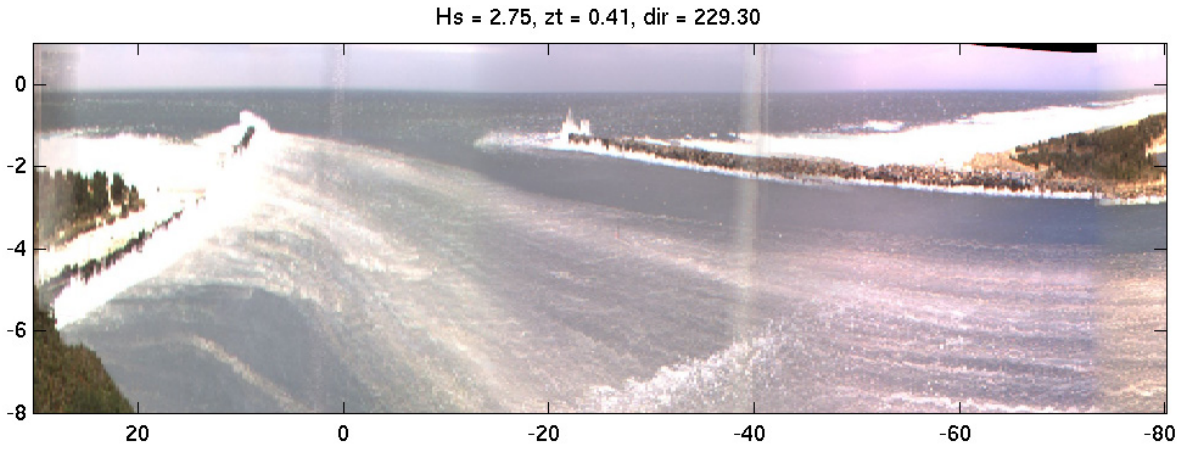
Figure 24. Pan “brightest” image of wave overtopping of the south jetty near the beach but not overtopping further offshore. Foam and perhaps sediment are being carried into the inlet by the flooding tide. Note the signature of breaking over Guano Rock.